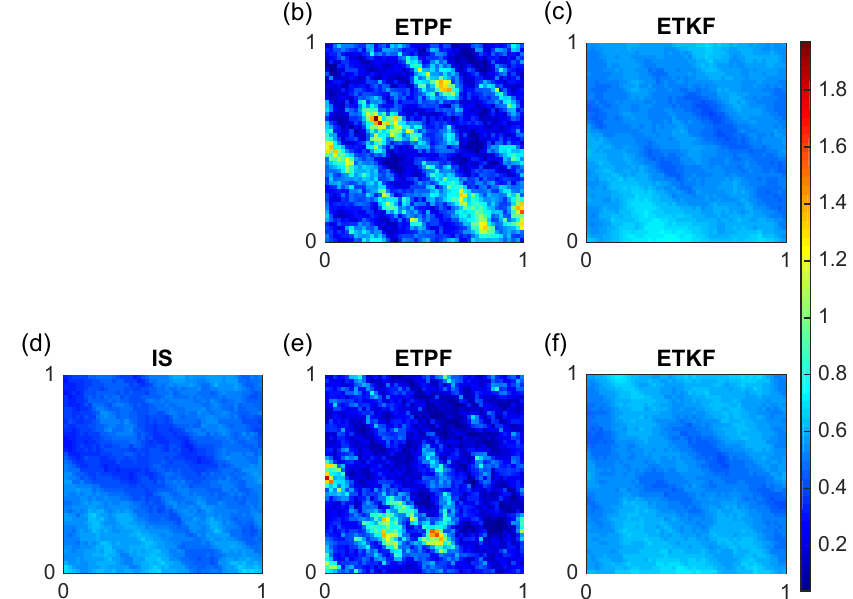
Figure 9. Variance of log permeability fields: obtained with ensemble size 10 5 by IS (d) , with ensemble size 10 3 by ETPF (b–e) , and ETKF (c–f) . Variance at the smallest RMSE (b–c) and at the largest RMSE (e–f) over